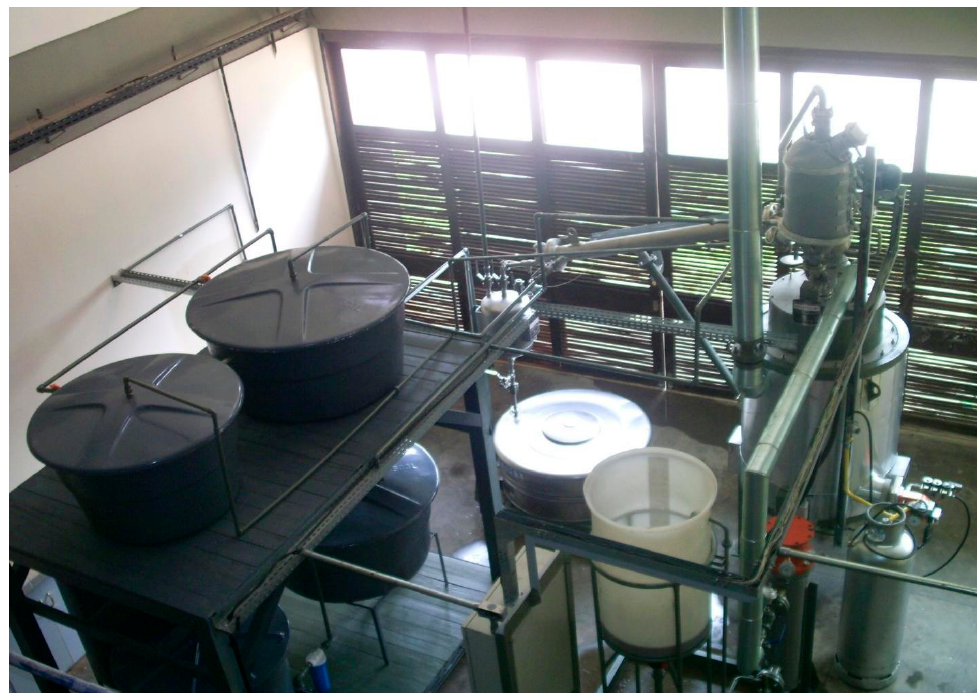
Figure 3. Depolymerization reactor of 143 L for thermic degradation of PMMA resin teeth + fragments of triturated empty rosettes at 345, 405, and 420 °C, atmospheric pressure, in pilot scale.